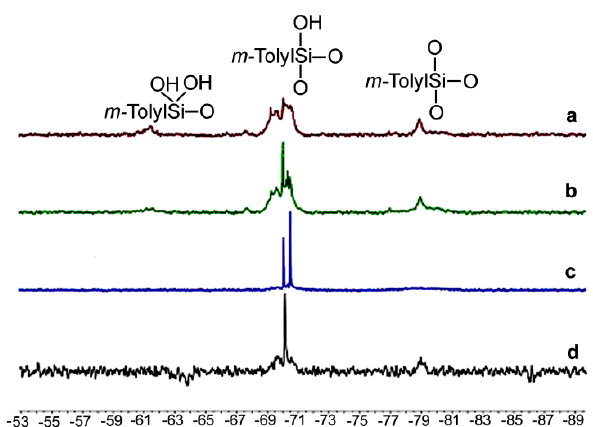
Figure 2. 29 Si NMR spectra of m -tolylcyclosiloxane compounds from the reaction of 1 carried out for 48 h at C HCl = 0.40 ( a ), 0.15 ( b ), 0.054 ( c ), and 0.038 mol L −1 ( d ).